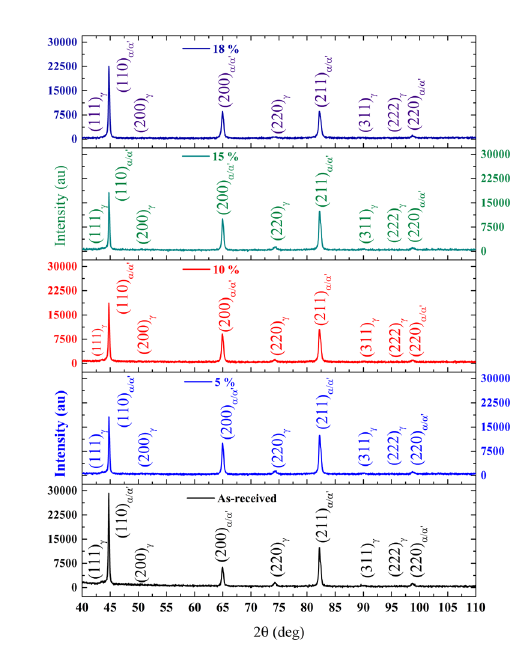
Figure 5. X-ray diffractogram patterns of TRIP780 steel sheet determined from the as-received condition and increasing pre-strain levels in uniaxial tensile